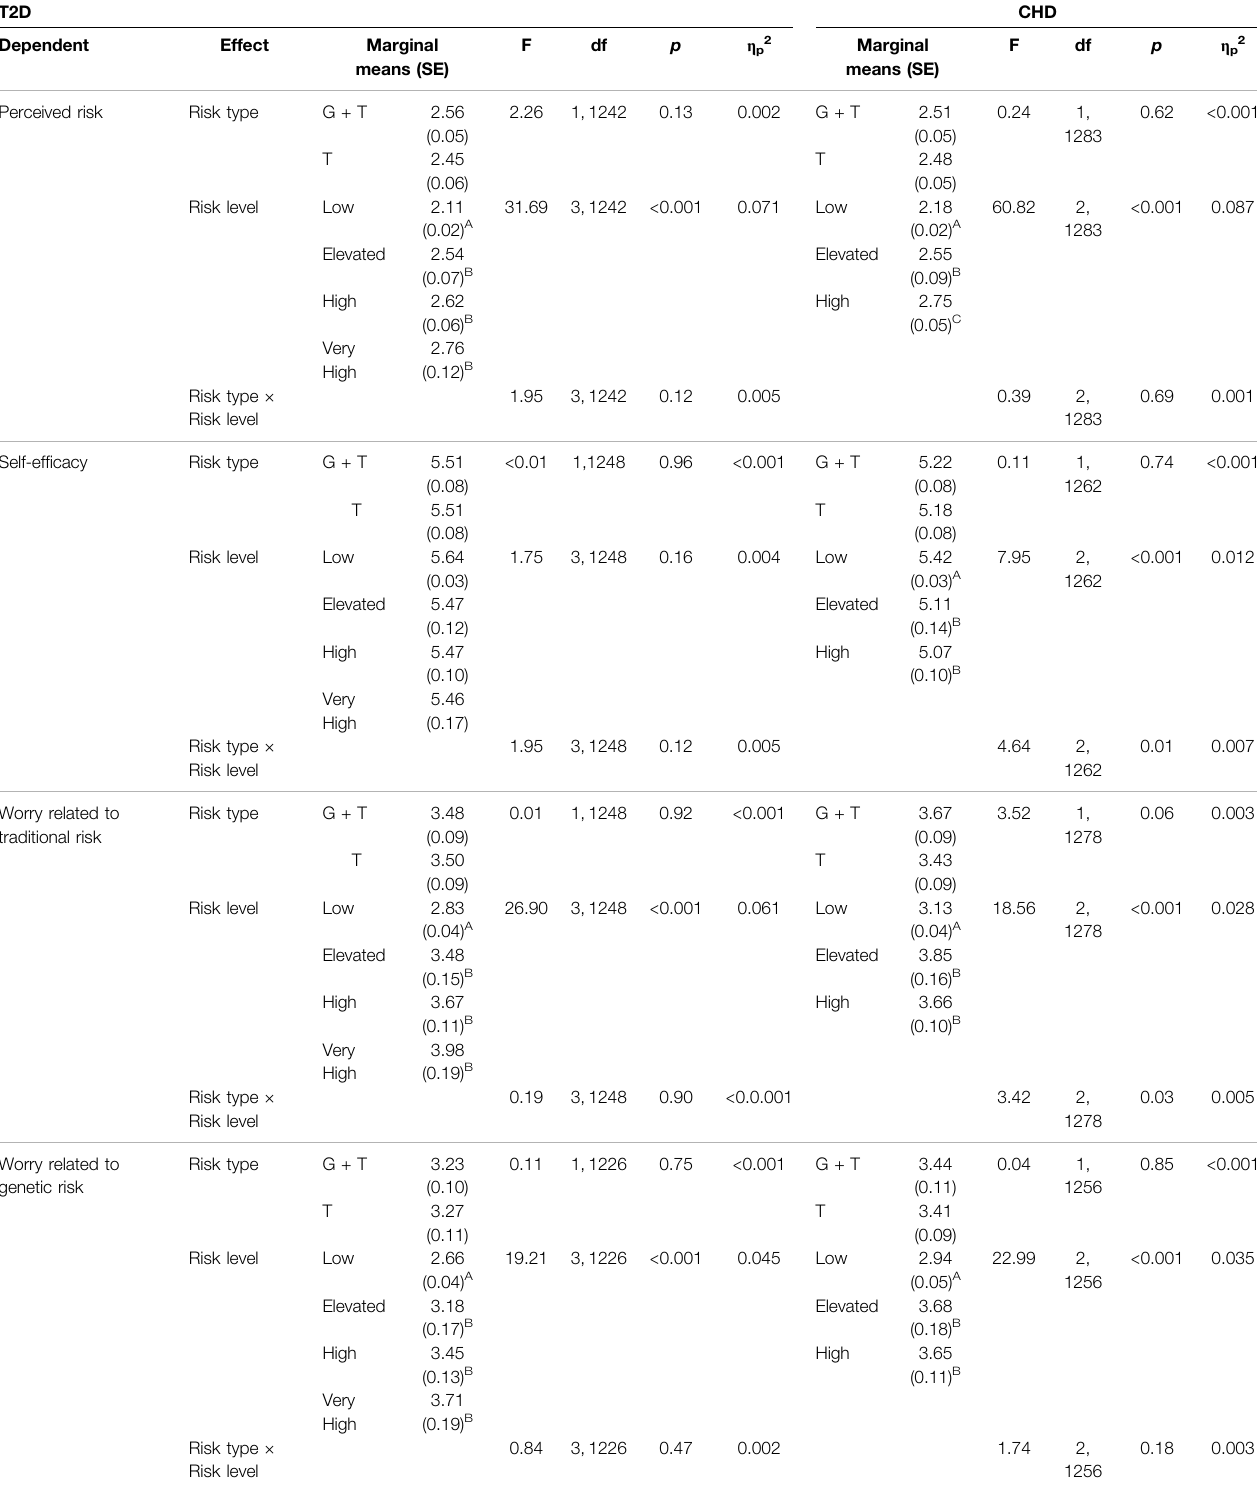
TABLE 2 | Analysis of covariance main effects and interactions: Perceived risk, self-ef fi cacy, and worry concerning T2D and CHD risk. T2D CHD p η p2 Dependent Effect Marginal F df p η p2 Marginal means (SE) means (SE) Perceived risk